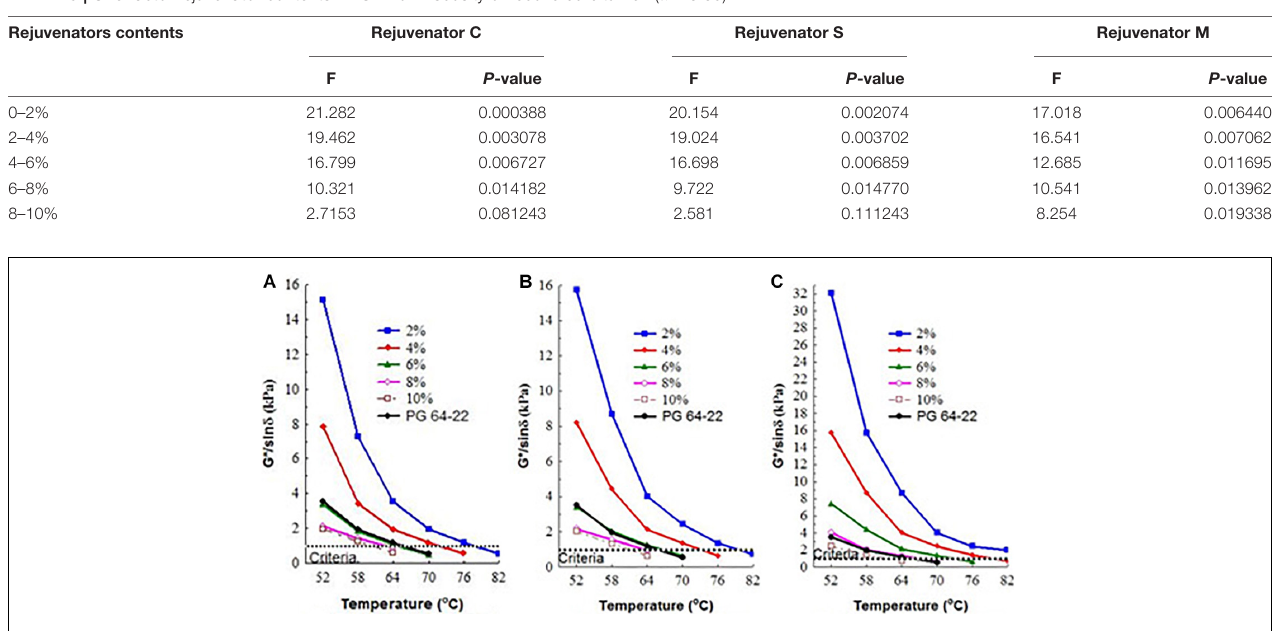
TABLE 5 | One-factor rejuvenator contents ANOVA on viscosity of recovered bitumen ( α = 0.05).